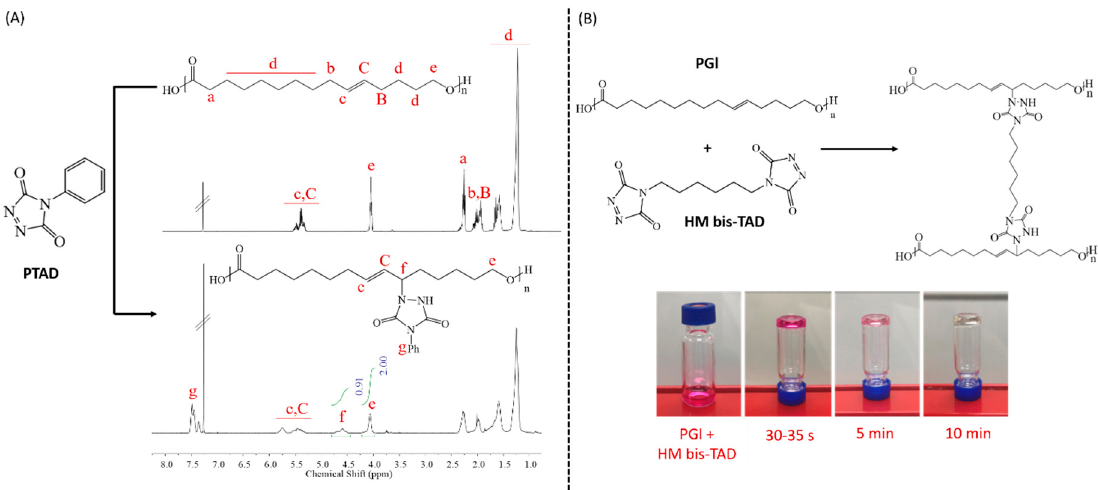
Figure 1. ( A ) Proton nuclear magnetic resonance ( 1 H-NMR) spectra of poly(globalide) (PGl), and PGl reacted with phenyl– TAD (PTAD); ( B ) reaction of PGl with hexamethylene bisTAD (HM – bisTAD).